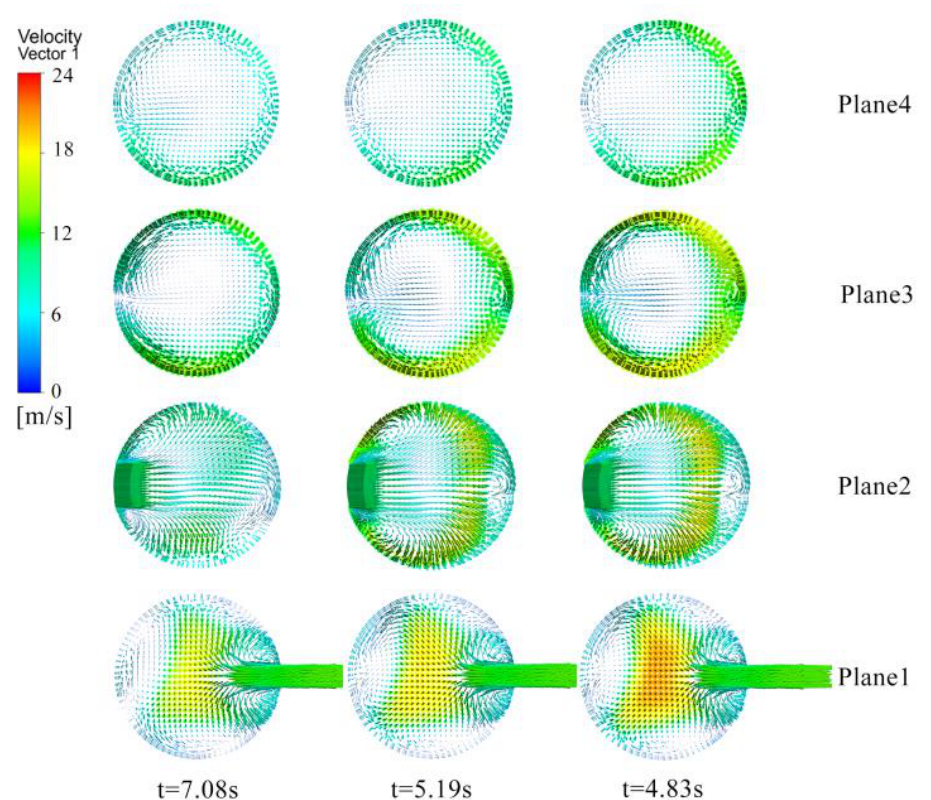
Figure 12. Velocity vector diagram of Z-axis sections under different particle residence time conditions.